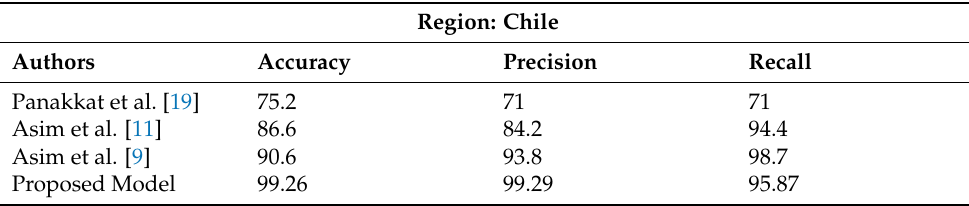
Table 10. Performance comparison of extant studies to proposed model for Southern Califor- nia